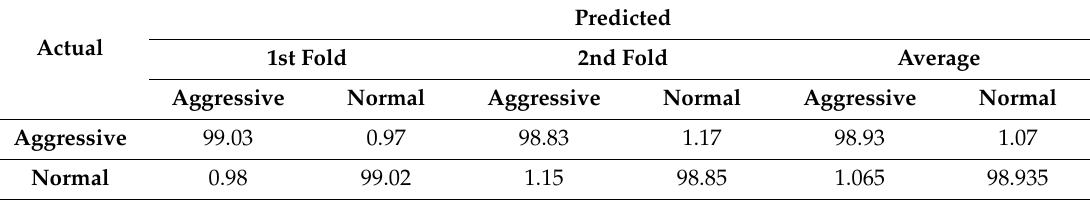
Table 9. Classification accuracies by proposed method, based on score-level fusion (%).